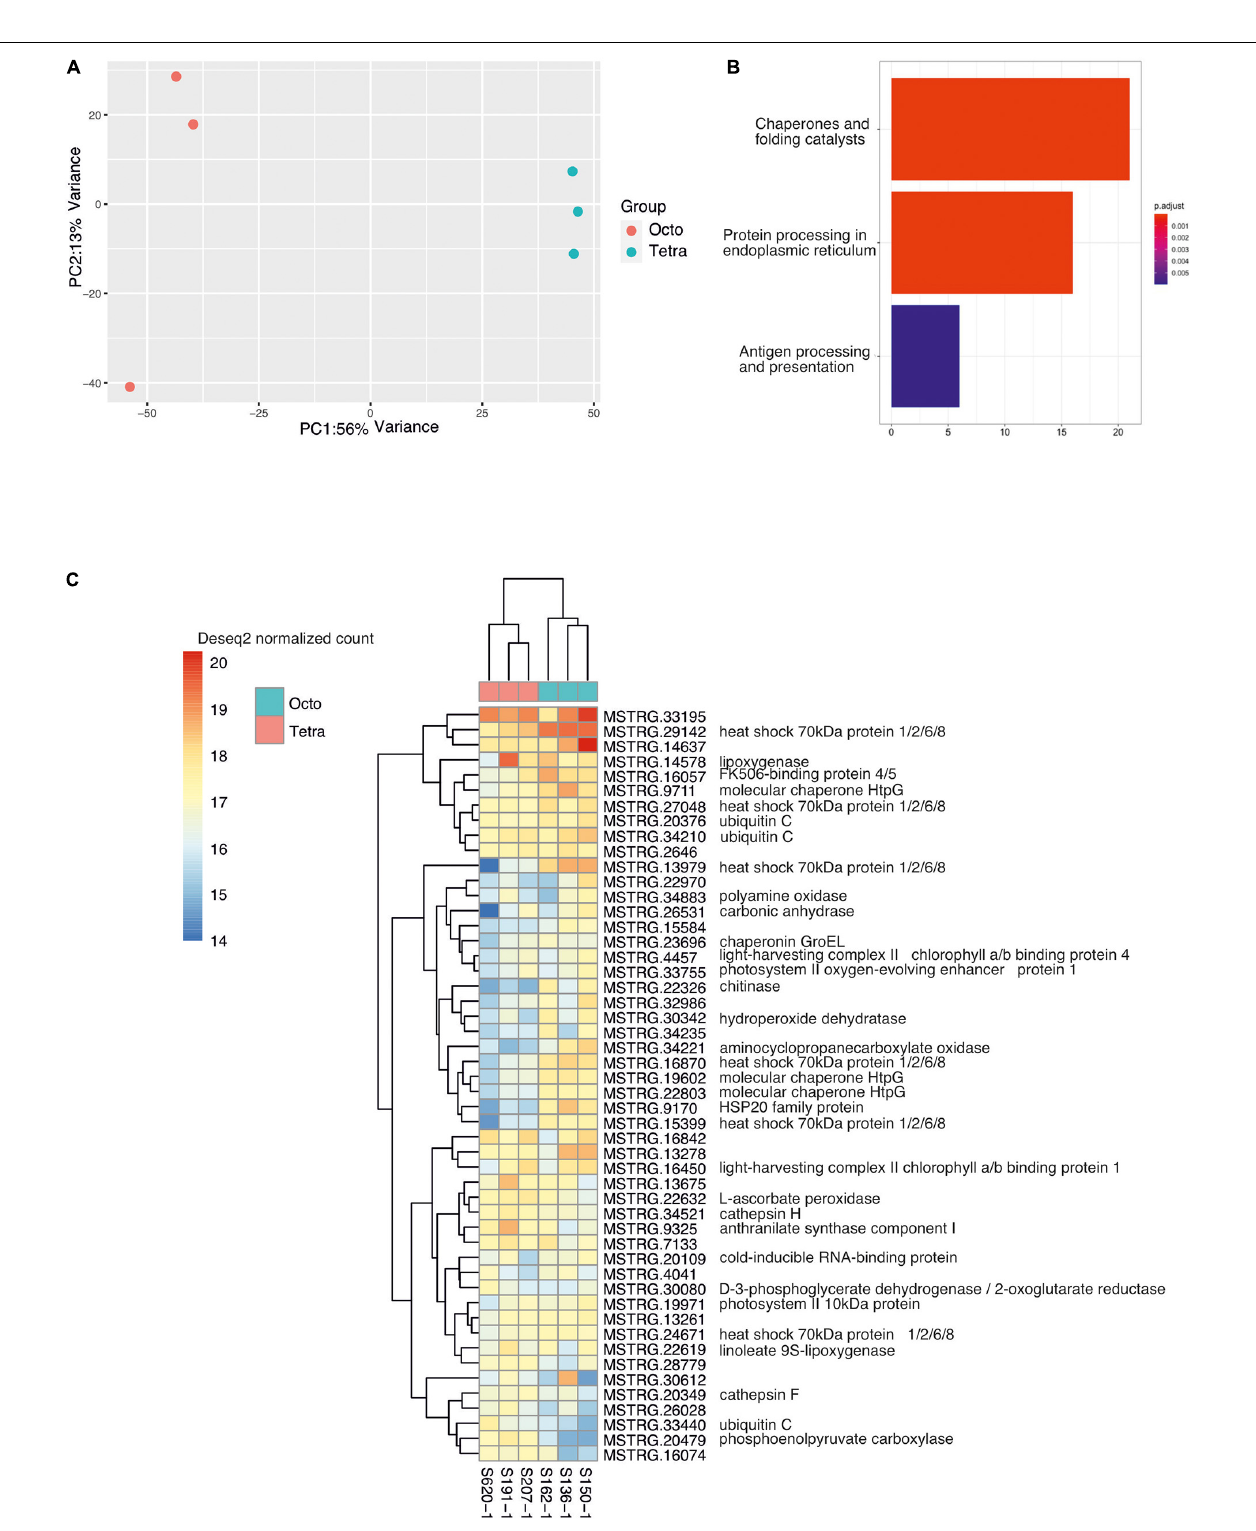
FIGURE 2 | Data visualization and differential gene expression of the transcripts between octoploid and tetraploid Phragmites australis . (A) Principal Component Analysis (PCA) of the transcript count transformed with rlog function from all samples. (B) Enriched Kyoto Encyclopedia of Genes and Genomes (KEGG) pathway of the genes that are upregulated in octoploids. The horizontal axis indicates number of genes. (C) Hierarchical clustering of genes with the highest mean of normalized counts across all samples. Abbreviated gene names are followed by a functional annotation of that gene.